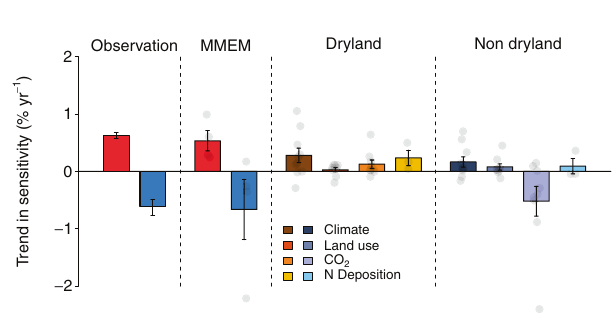
Fig.2|Changeinvegetationvariabilitycausedbyprecipitation.a TrendinNDVI variability caused by precipitation ( σ NDVI prec ). σ NDVI prec is calculated as the standard deviation of the NDVI anomalies contributed by precipitation ( θ prec × precipitation anomaly) within each 60-month window. b Time series of σ NDVI prec